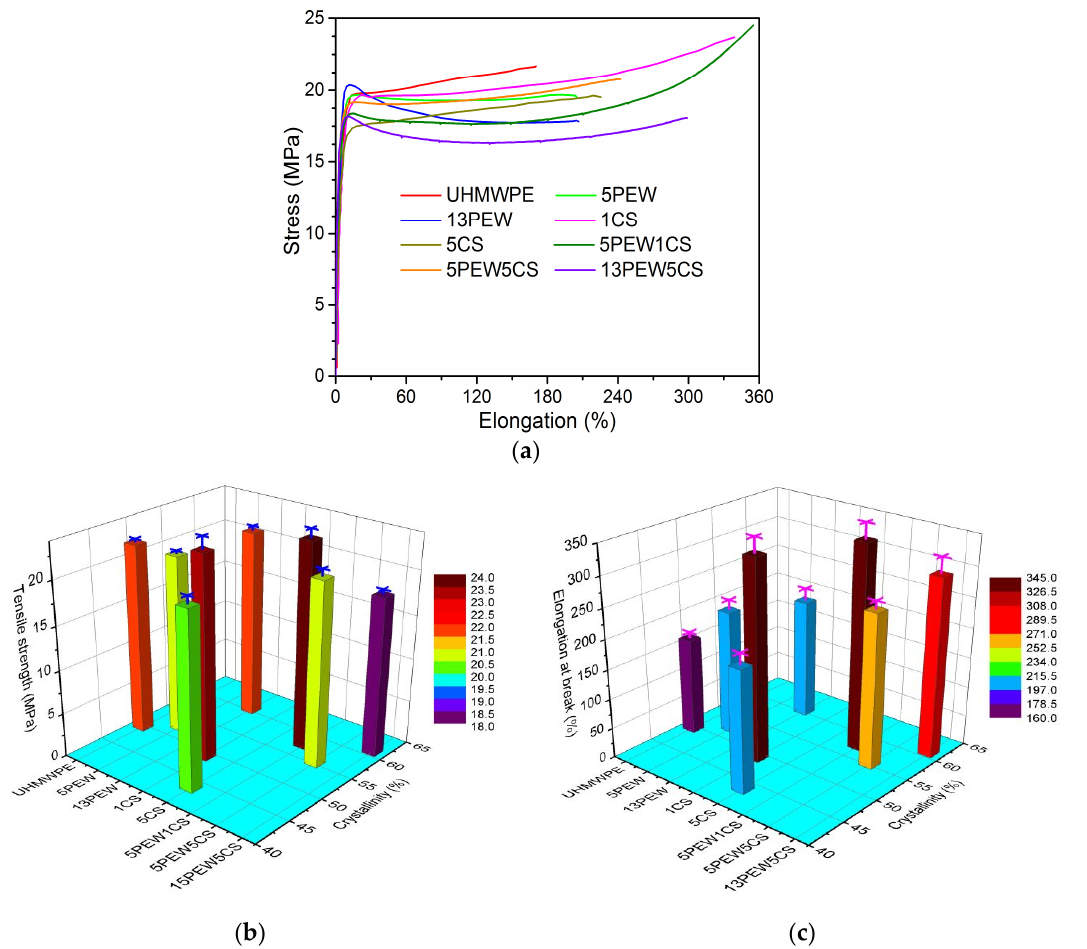
Figure 6. Tensile tests of the samples: ( a ) representative stress–elongation curves; ( b ) tensile strength; ( c ) elongation at break.